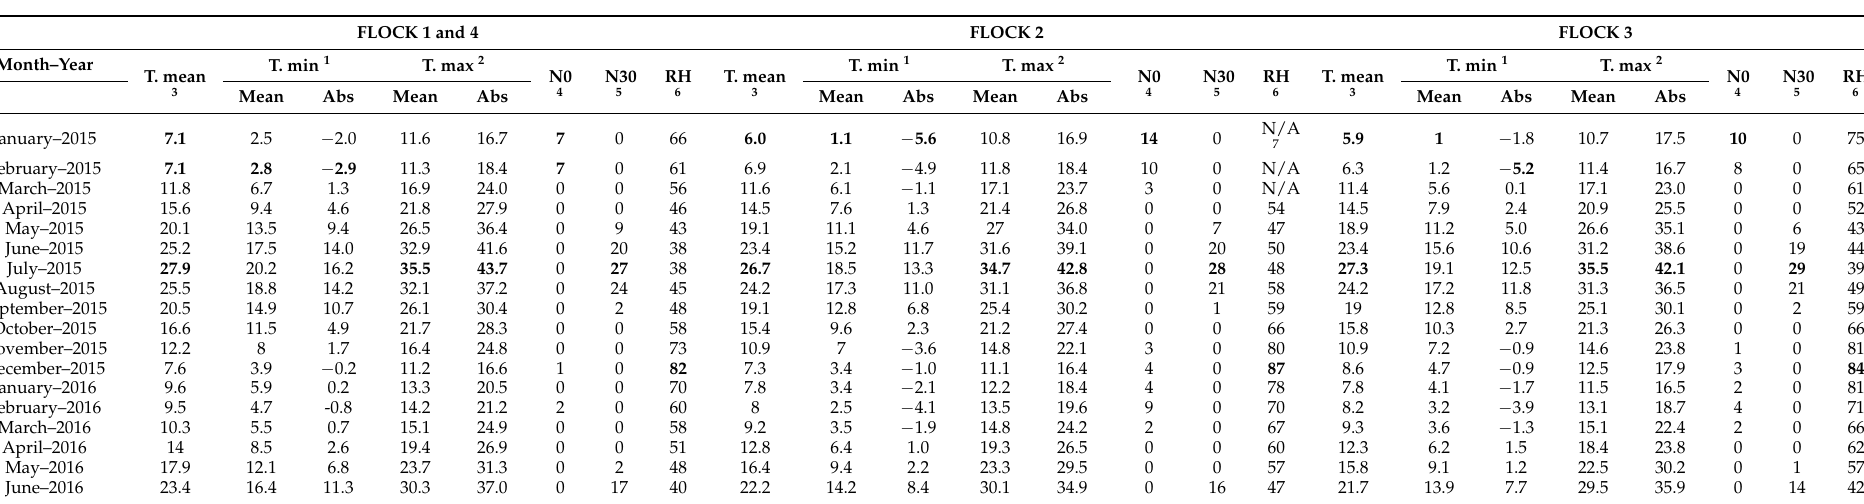
Table A1. Climate conditions along the experiment. Higher and lower temperatures during the experiment are in bold. Higher relative humidity along the experiment is indicated in bold. Data obtained from the State Meteorological Agency (AEMET) of the Spanish Government